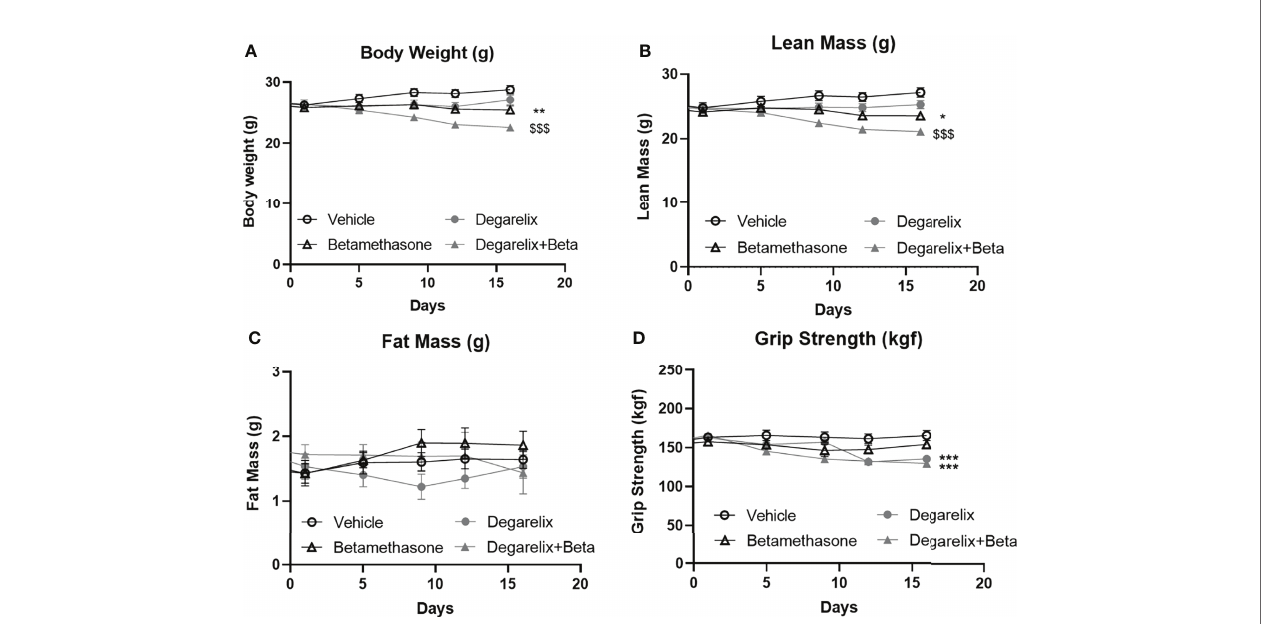
FIGURE 7 | Daily betamethasone treatment reduces total body weight and lean mass in intact and chemically-castrated male mice. The effect of daily treatment with 3 mg/kg betamethasone in chemically-castrated mice and intact mice on (A) total body mass, (B) lean mass, (C) fat mass, and (D) fore limb grip strength. N=8 mice/group. *p<0.05 vs. Vehicle, **p<0.01 vs. Vehicle, ***p<0.001 vs. Vehicle, $$$ p<0.001 vs degarelix. Statistical signi fi cance was calculated using a two-way